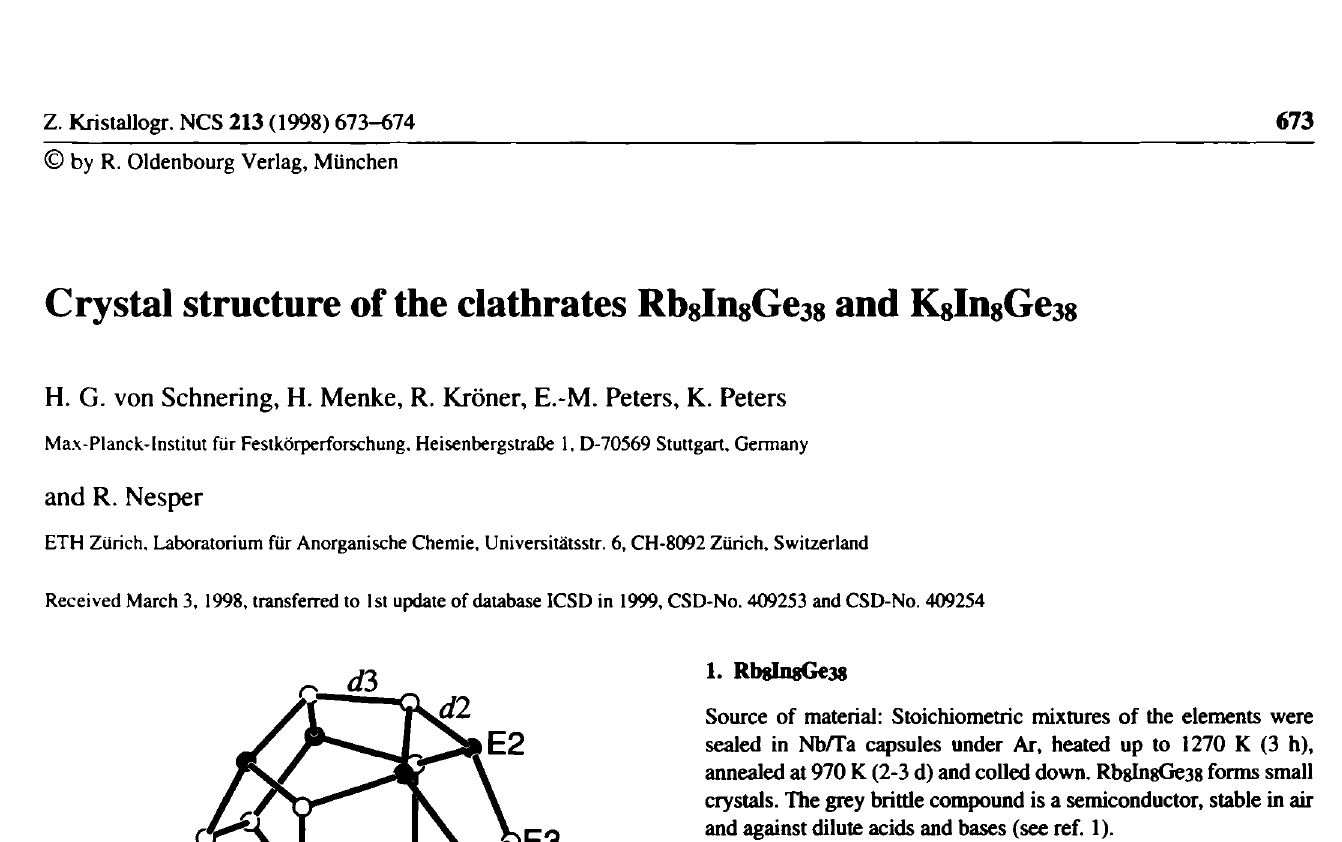
Table 1. Parameters used for the X-ray data collection Crystal: